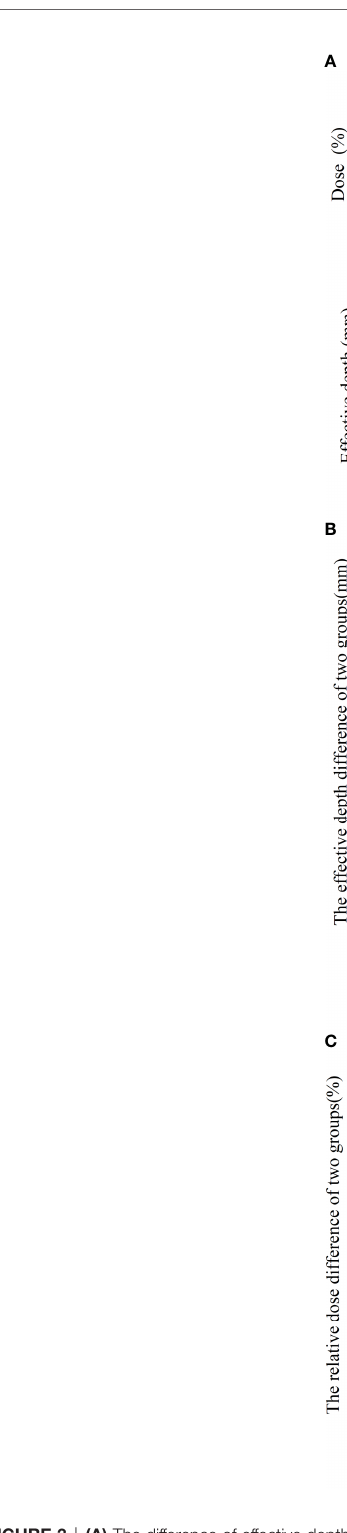
FIGURE 3 | (A) The difference of effective depth and corresponding dose of all beams for all patients. We knew that the absolute effective depth difference generally remained at a level of 1 mm, but the dose difference was quitely fl uctuated sometimes more than 20%. (B) The effective depth difference of inhomo-case vs. homo- case on median. (C) The relative dose of inhomo-case vs. homo-case on median. They were all statistically signi fi